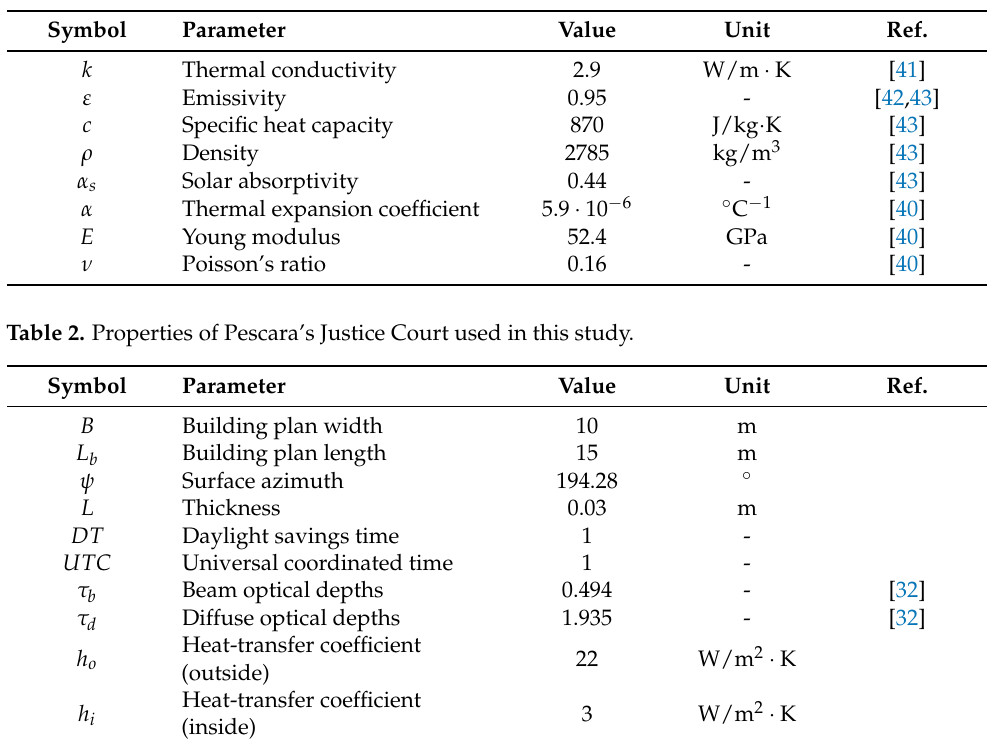
Table 1. Properties of the Carrara marble used in this study.